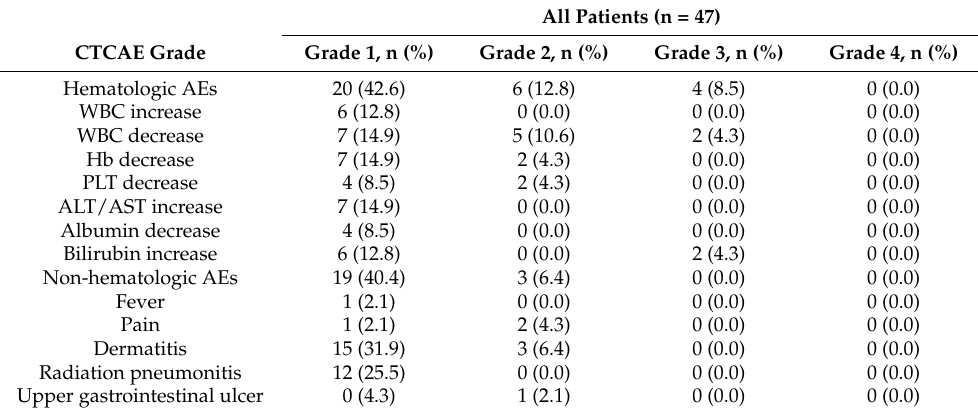
Table 4. Adverse events related with proton beam therapy.